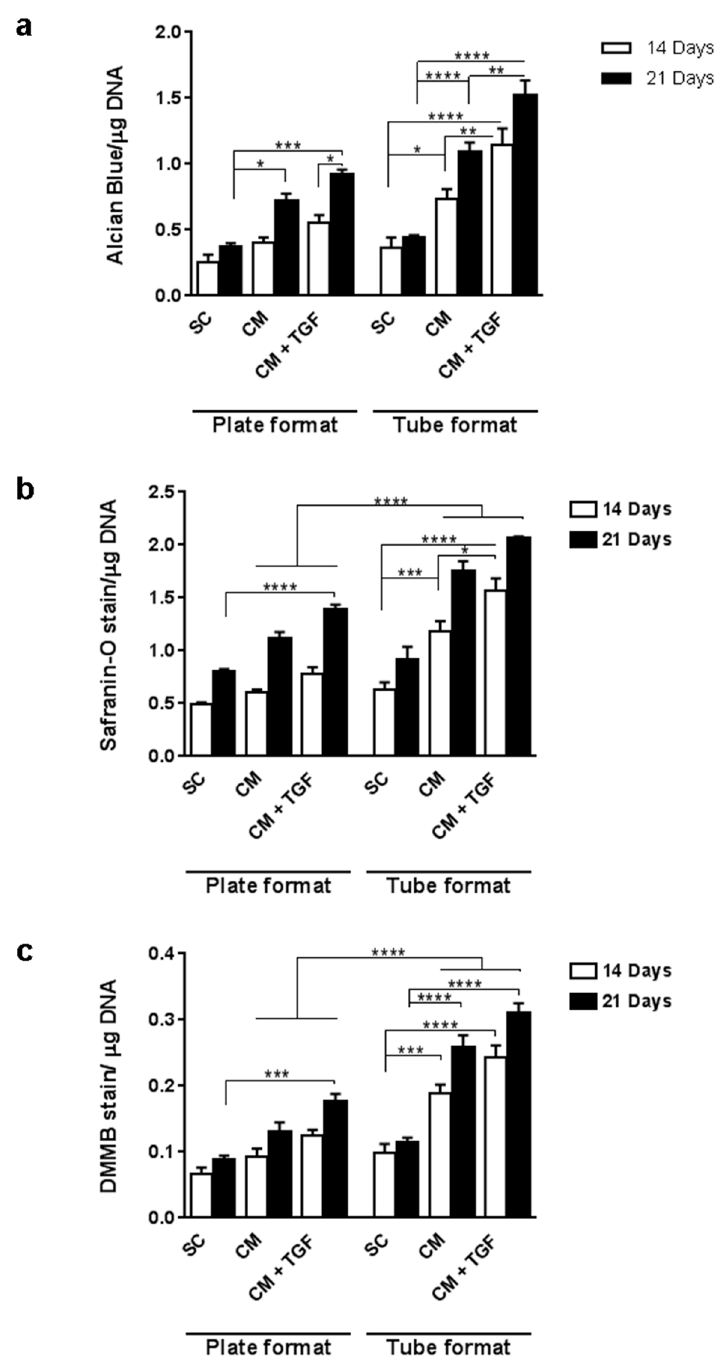
Figure 5. Comparison of MSC response to chondrogenic conditions analysed in 3D using micropellets (V-shape 96-well plates) and 15 mL falcon tubes. Cultures were analysed by Alcian Blue ( a , n = 4), Safranin-O ( b , n = 4) and DMMB ( c , n = 8) assays at 14 and 21 days. * p < 0.05, ** p < 0.01, *** p < 0.001, **** p < 0.0001. SC: standard culture medium, CM: chondrogenic differentiation medium, CM + TGF: chondrogenic medium supplemented with TGF- β 1.